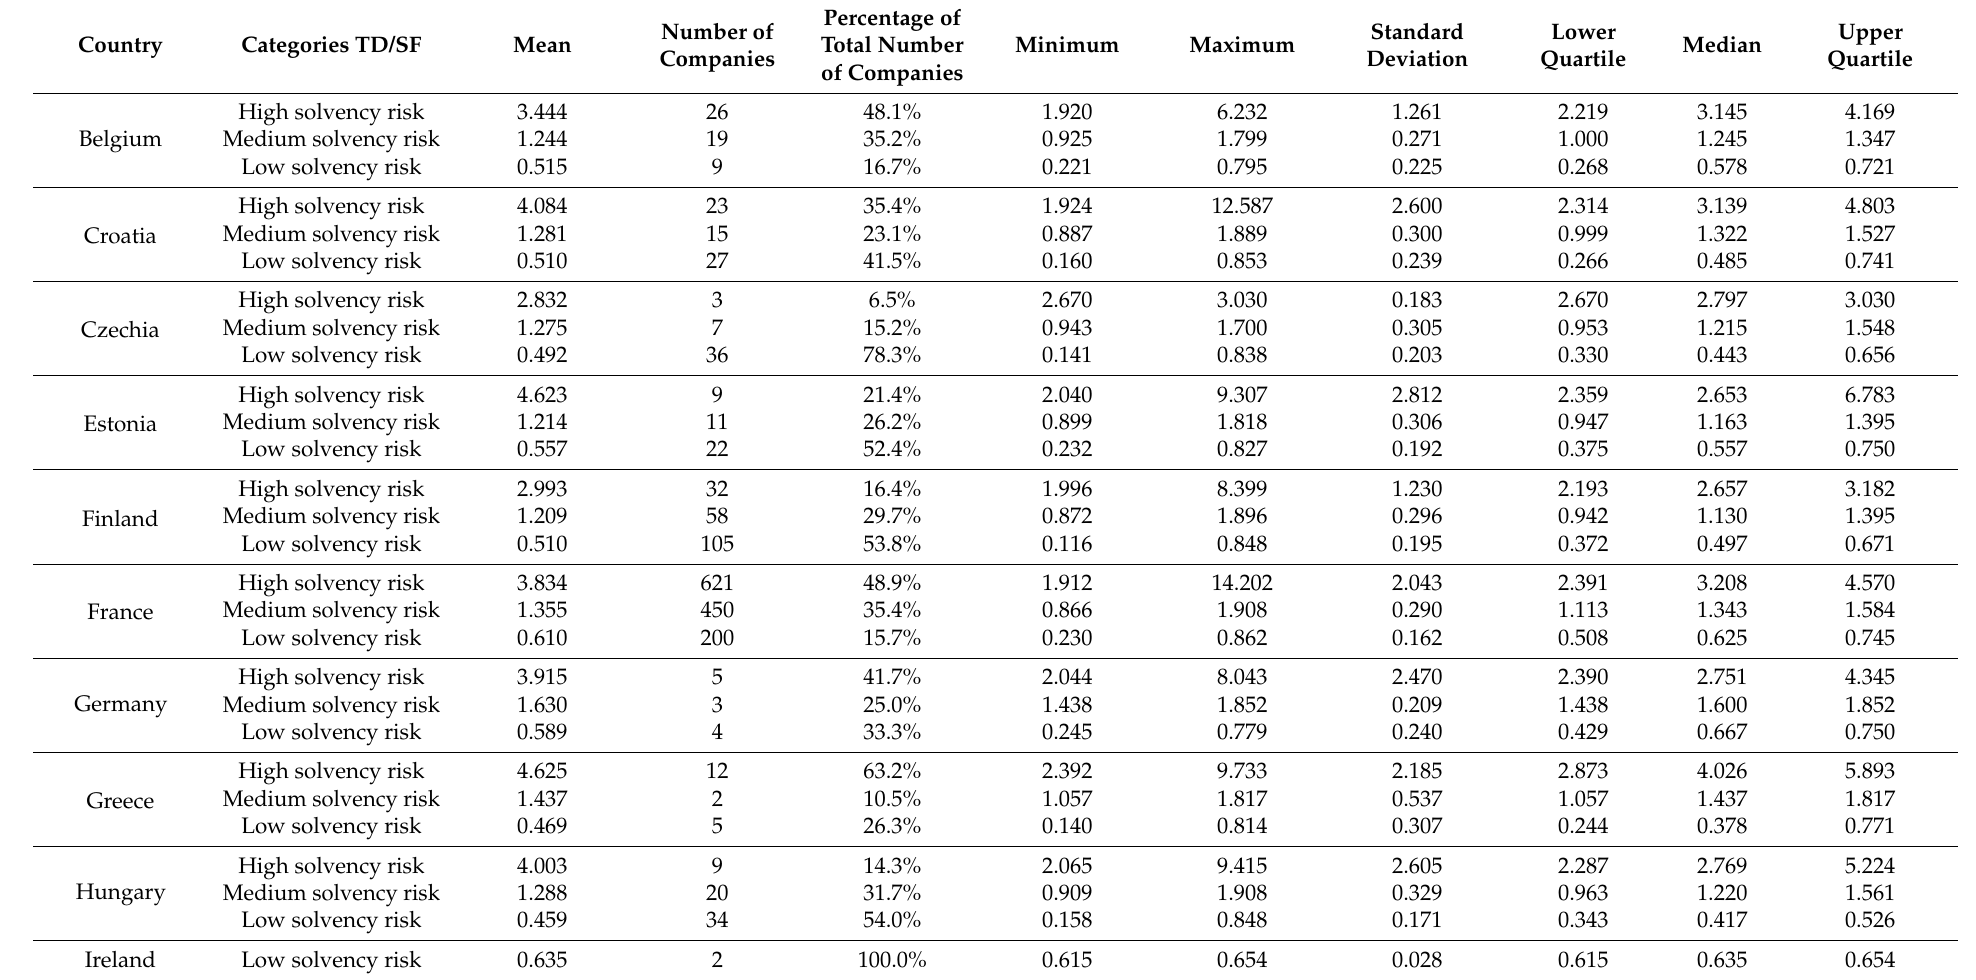
Table A2. Distribution of companies and descriptive statistics for TD/SF median,